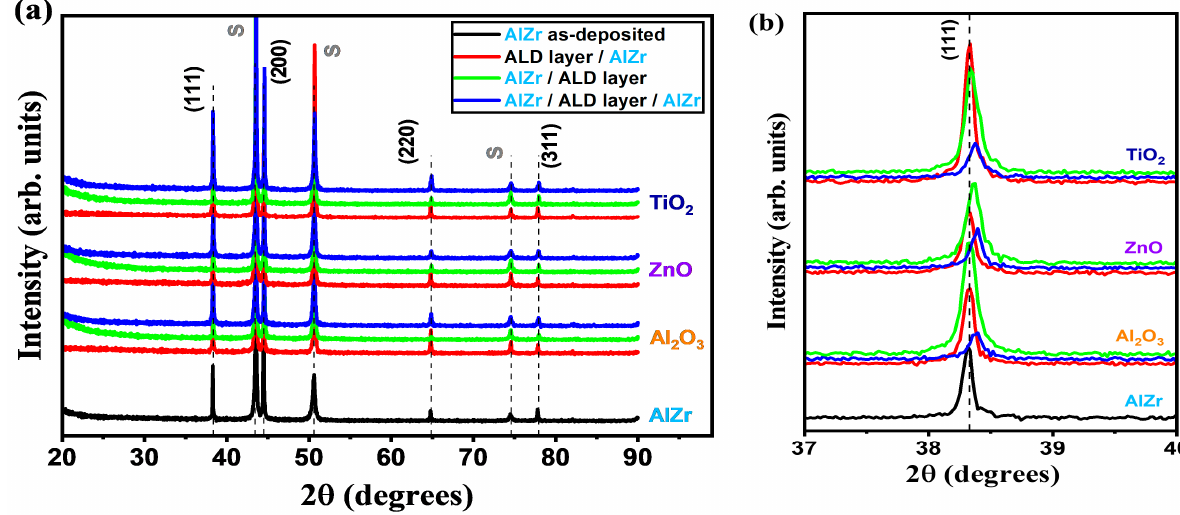
Figure 5. ( a , b ) XRD patterns of the coatings. Table 1. Lattice parameter, crystallite size, and texture coefficient of samples 0# to 3# and 7# to 9#.